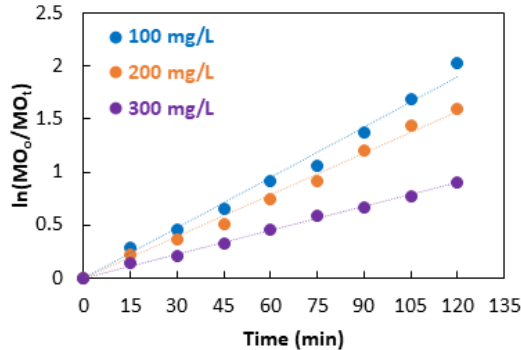
O catalyzed 3 4